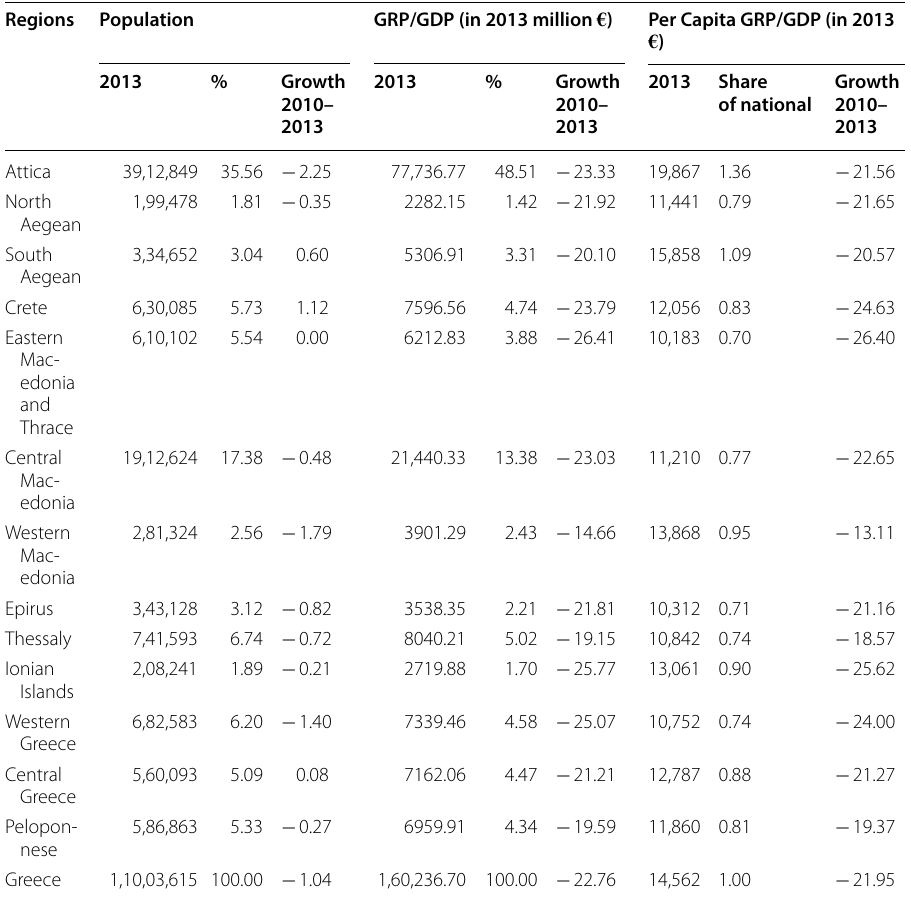
Table 1 Basic socioeconomic indicators for Greece, 2010–2013. Source: Hellenic Statistical